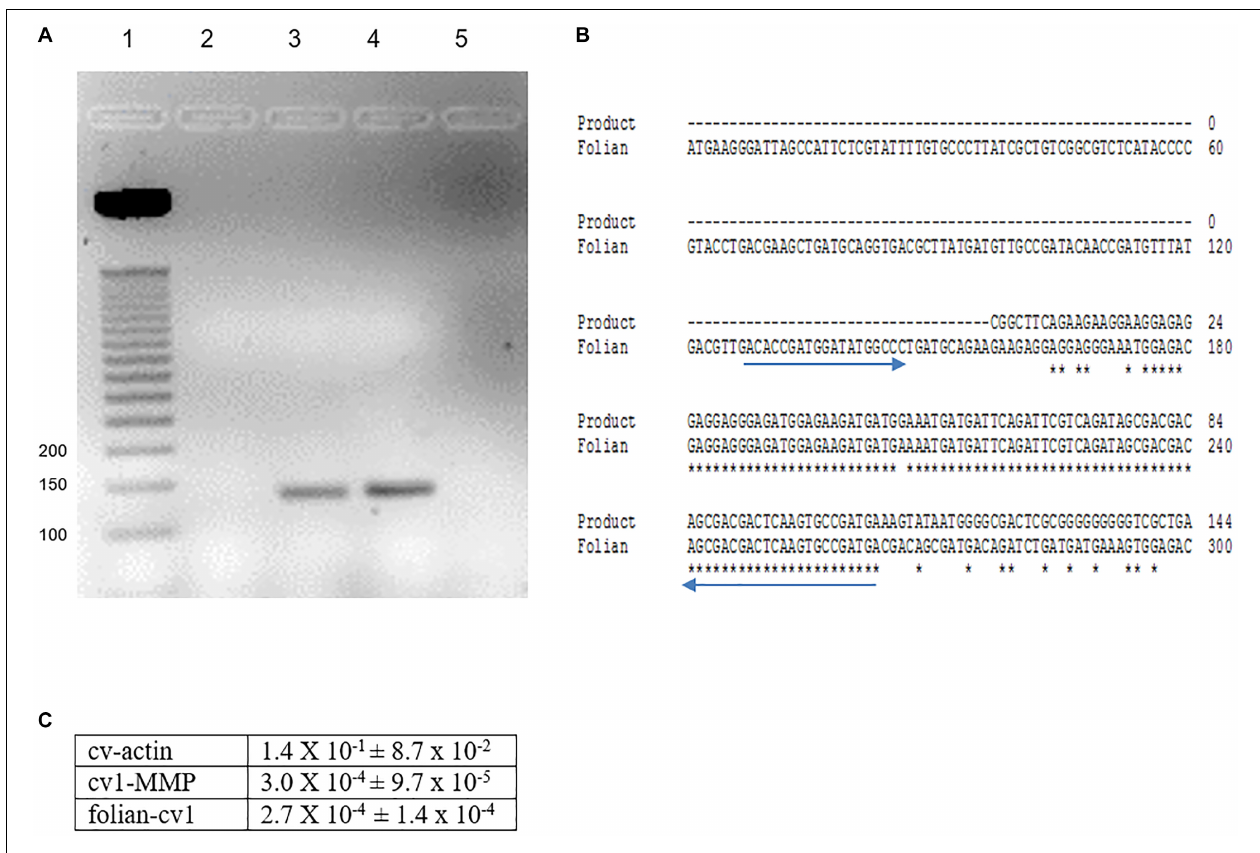
FIGURE 5 | Identification of folian-cv1 gene expression in mantle tissue and hemocytes. (A) PCR products amplified from mantle and hemocytes using folian-cv1 forward and reverse primers resolved on a 2% agarose gel and stained with EtBr. Lane 1- standards labeled in base pairs; Lane 2- negative control, no template; Lane 3- hemocytes; Lane 4- mantle tissue; Lane 5-blank. The products are similar in size to the length of the region delimited by the primers (135 bp). (B) Sequence validation of PCR target. The PCR product from hemocytes was sequenced and aligned with the folian-cv1 gene sequence. Primers indicated with blue arrows. High fidelity matching occurred between nucleotides 159 and 266 on the folian-cv1 sequence. (C) Comparison of qPCR expression for cv-actin, cv1-MMP and folian-cv1 in hemocytes. Values are relative to cv-18S rRNA expression (Mean ± standard deviation; N = 3 hemocyte